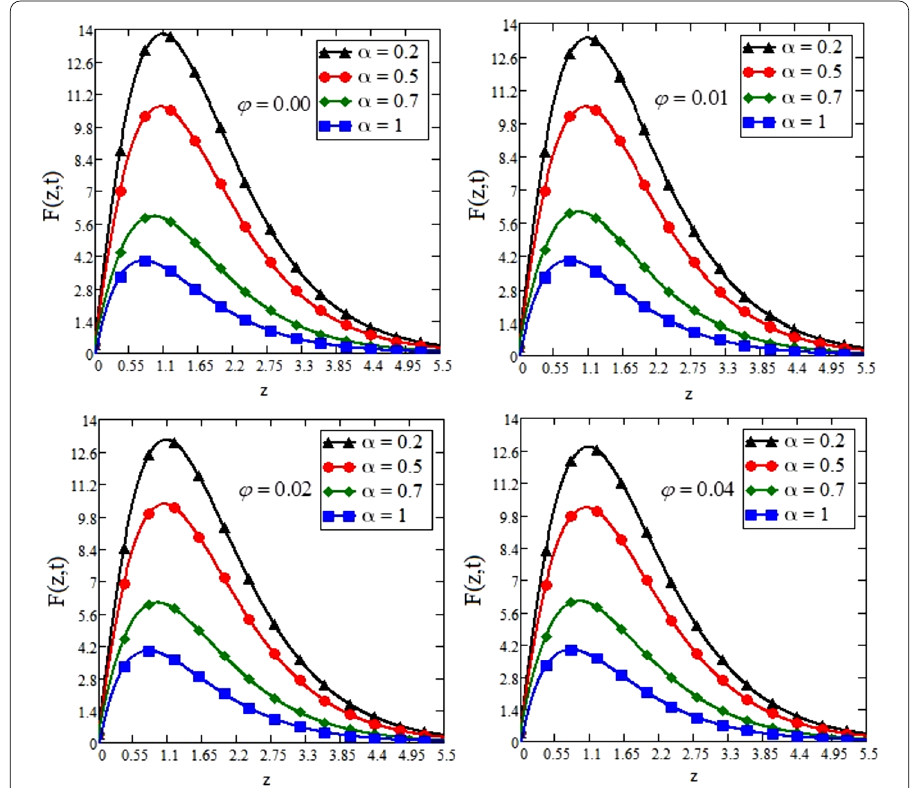
Figure 2 Impact of ϕ on the velocity distribution of Jeffrey